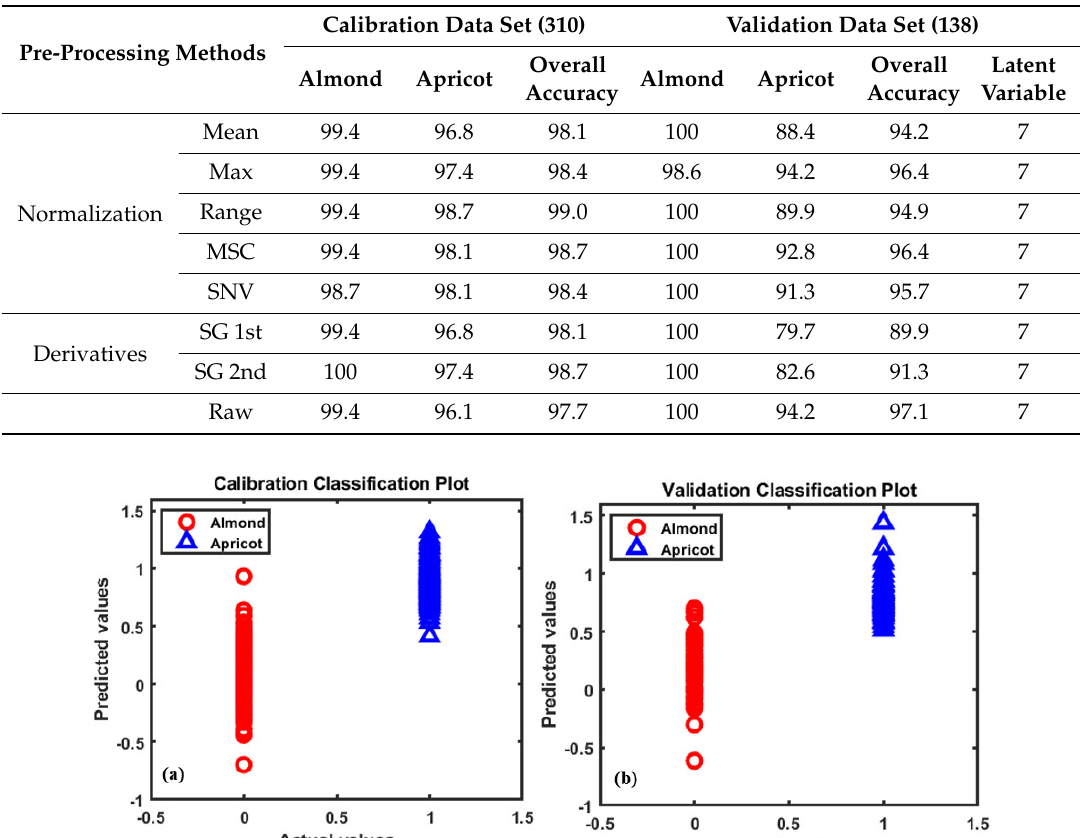
Table 1. The partial least square discrimination analysis (PLS-DA) analysis results were obtained for the classification of adulterated almonds.